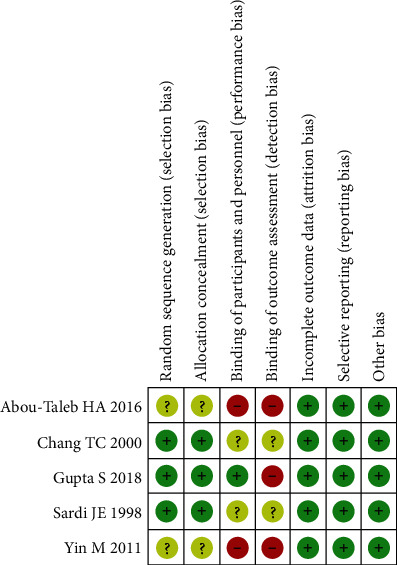
Risk of bias summary for the five included studies.